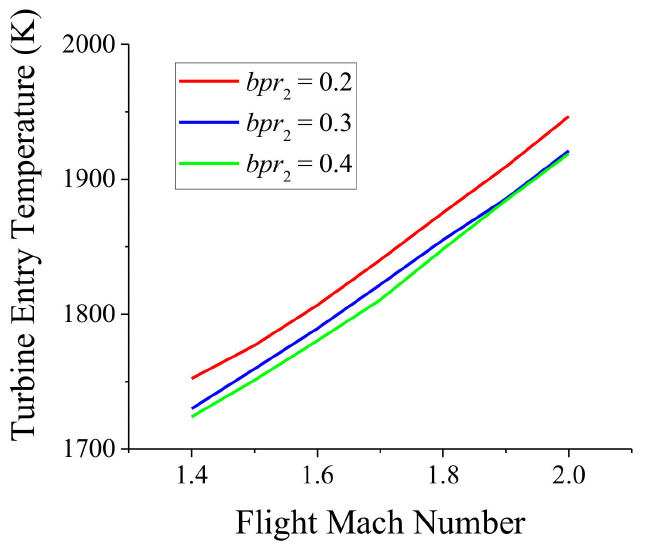
Figure 14. The Variations of Turbine Entry Temperature at the conditions of Different Second Bypass Ratios ( bpr 2